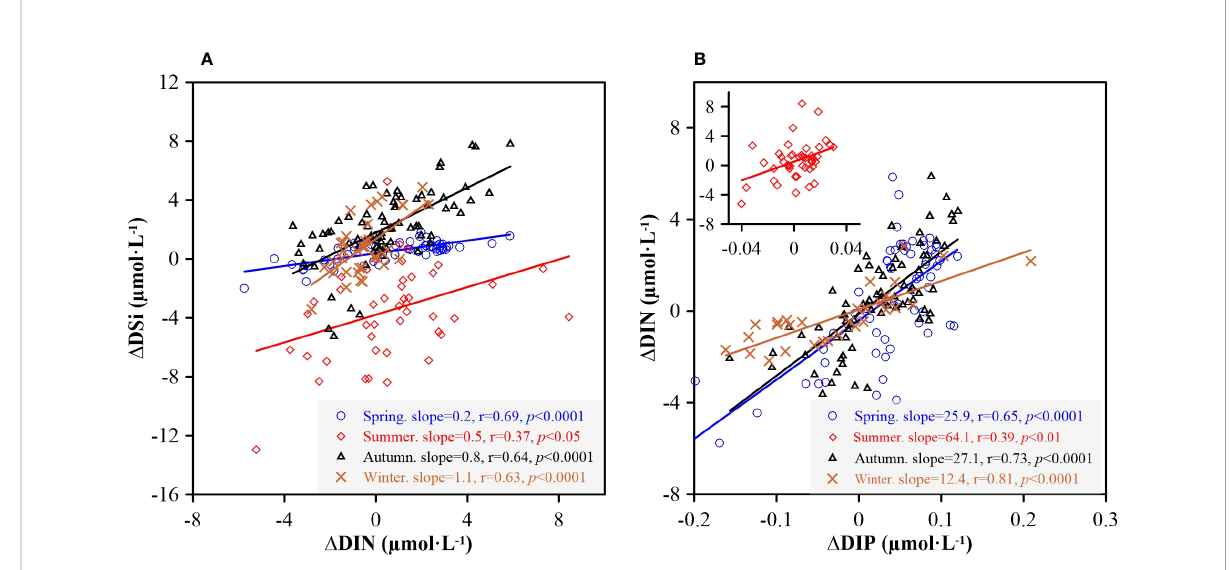
FIGURE 12 Relationship between D DSi vs . D DIN (A) and D DIN vs . D DIP (B) in euphotic